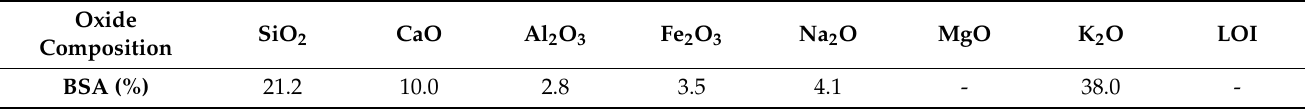
Table 11. Oxide composition of BSA [96].